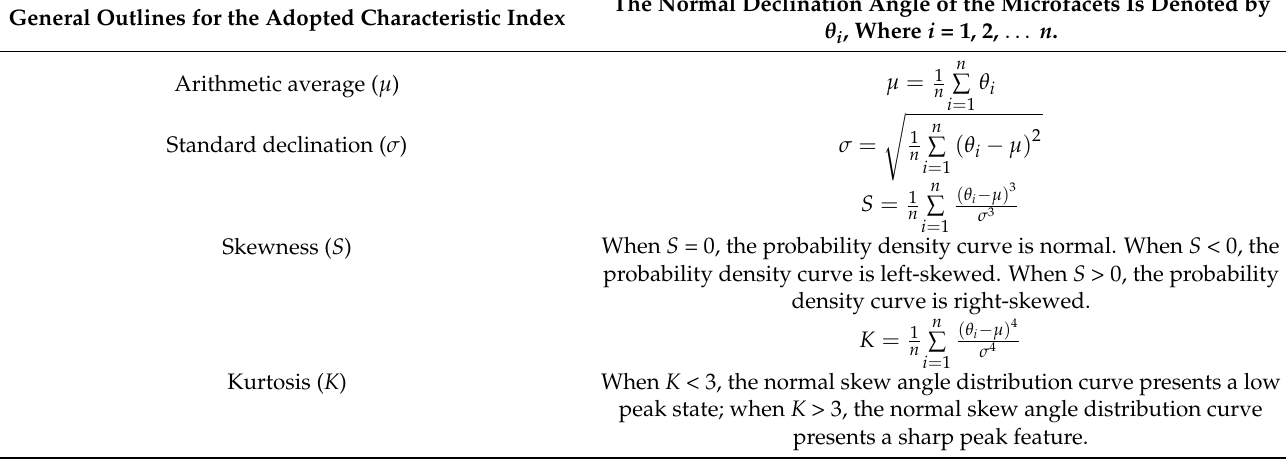
Table 1. The adopted distribution characteristic index.